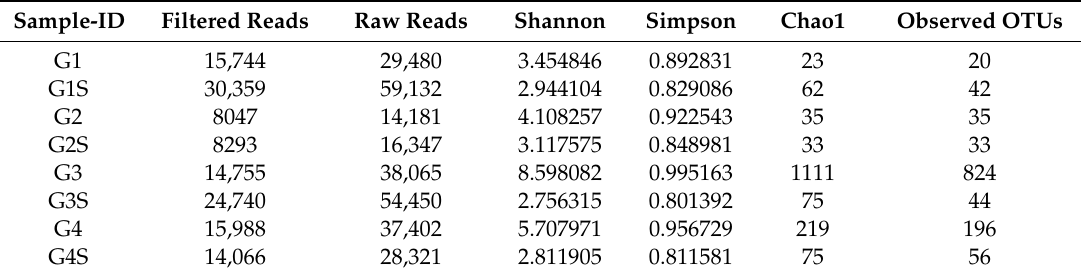
Table 2. Sample information, microbial diversity and sequence abundance.